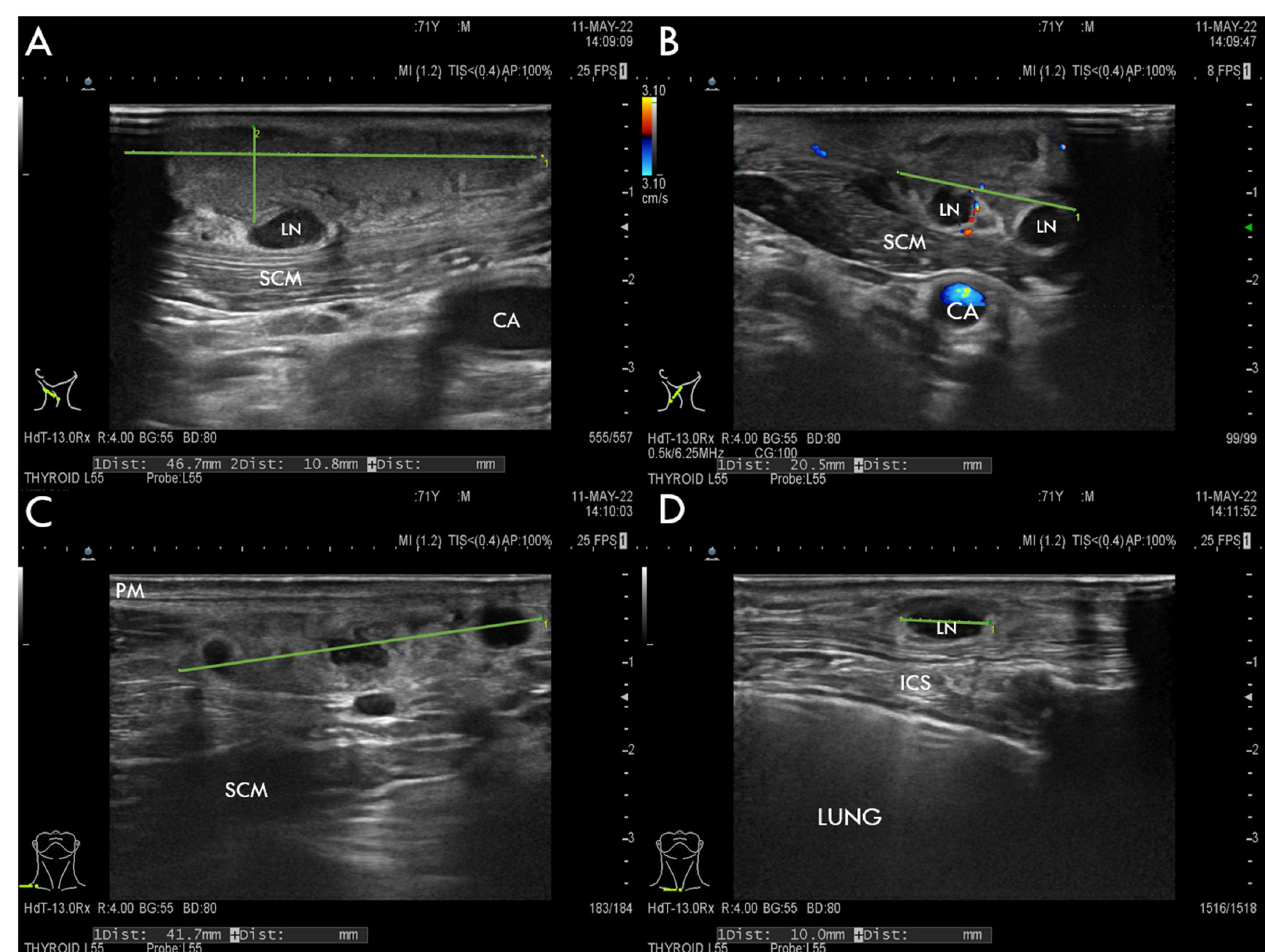
Figure 1. Ultrasonographic neck evaluation of the patient with ulceroglandular tularemia. ( A ) The hypoechoic area of 5 cm × 1 cm × 2 cm (green lines) corresponds to inflammatory changes in subcutaneous fat involving the platysma muscle (PM) above the sternocleidomastoid muscle (SCM) with abnormal adherent lymph node (LN); ( B ) Doppler ultrasonography shows the absence of blood flow in liquid-filled structures above SCM, which corresponds to partly colliquated abnormal lymph nodes (green line) and a non-compressible arterial flow under SCM, which corresponds to the carotid artery (CA); ( C ) a conglomerate of abnormal partially colliquated lymph nodes (green line) above SCM; ( D ) a conglomerate of abnormal 40 mm × 7 mm large supraclavicular lymph nodes overlying the intercostal space (ICS). Panels ( A – C ) anatomically correspond to a blue and red arrow in Figure 2. Panel ( D ) anatomically corresponds to the black arrow in Figure 2.